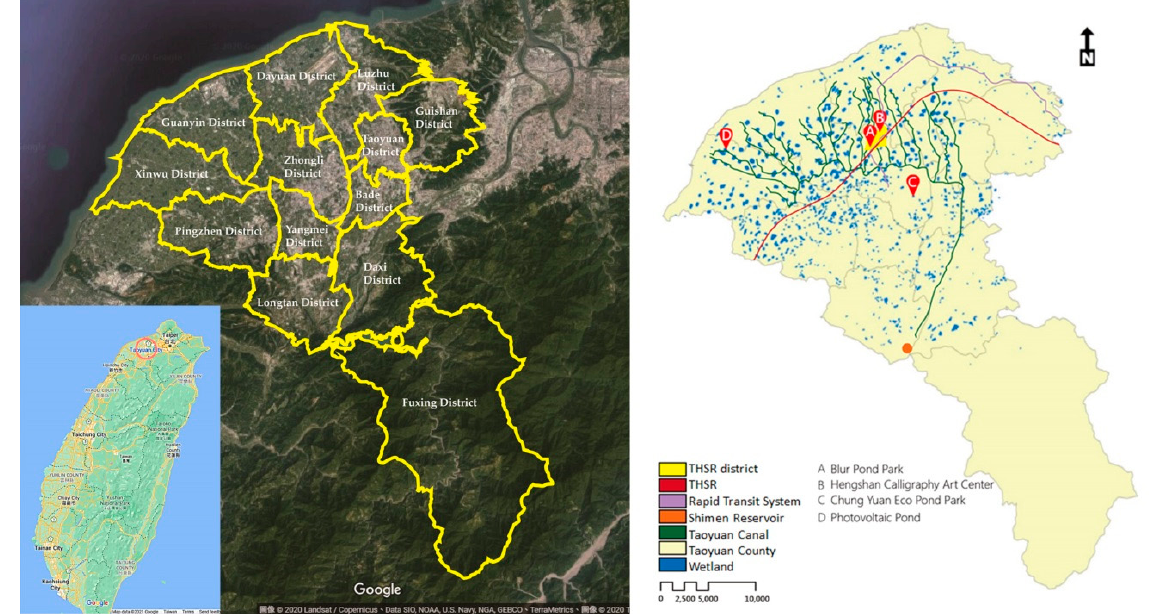
Figure 5. Pond distribution ( left ) and wetland conservation boundary ( right [47], adapted from Urban and Rural Development Branch) in Taoyuan.